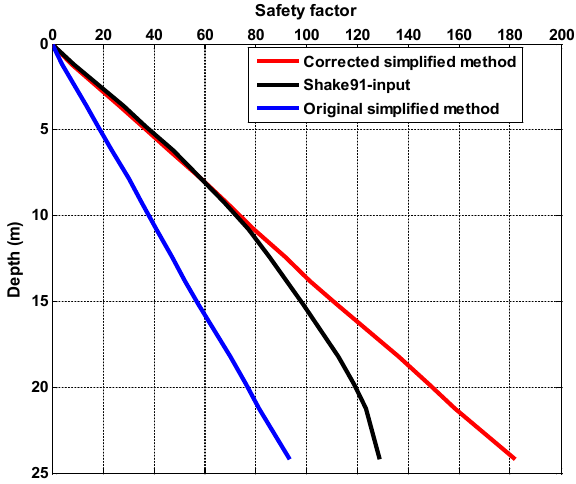
Figure 10: Maximum shear stress according to depth with dynamic and simplified analysis (Yuanlin site).